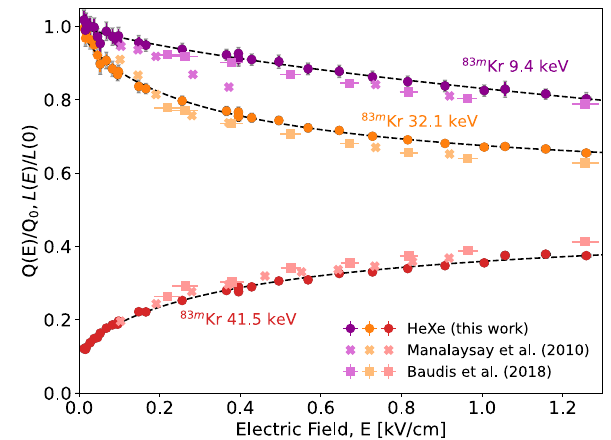
Fig. 15 Anti-correlation of charge and light for the 41.5keV line of the 83m Kr source (red) and for the alpha particles of 222 Rn and 218 Po in the lower left inset. Only data points with a drift field above 70V/cm are shown as only those are used for the fit. For better visibility, the data points of 214 Po are not shown in the inset